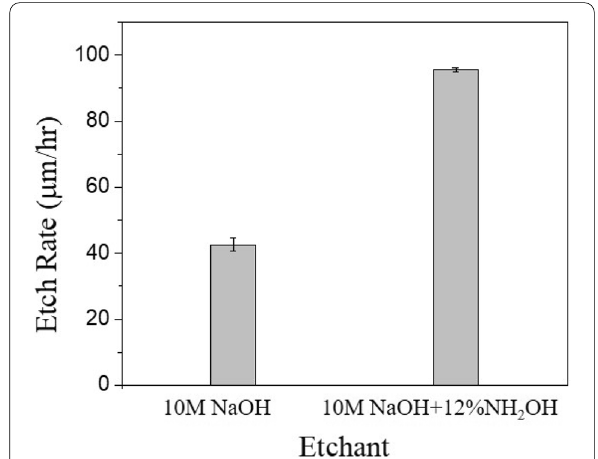
Fig. 1 Etch rate of Si{100} in 10 M NaOH without and with addition of 12% NH 2